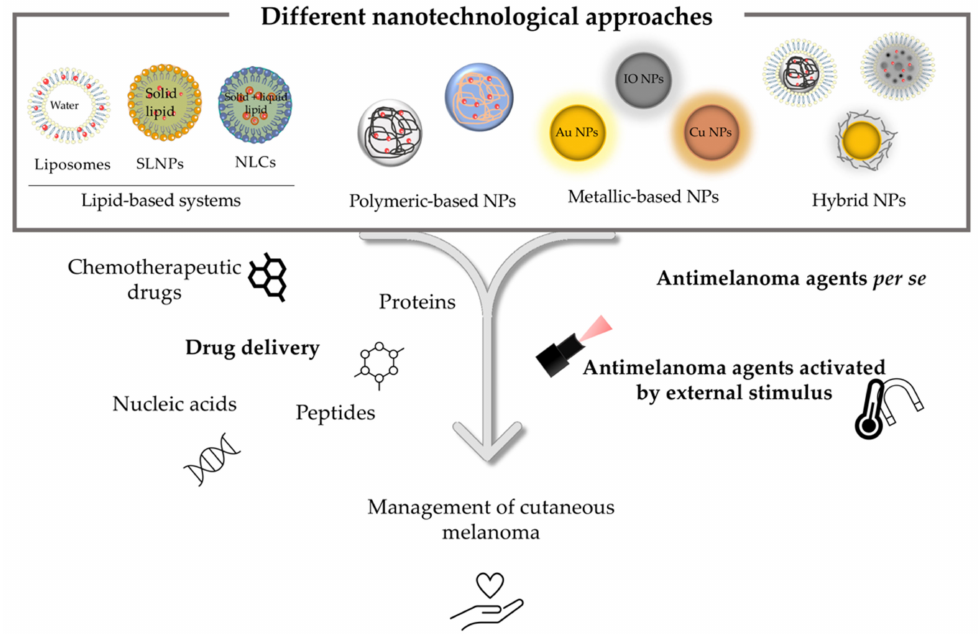
Figure 2. Schematic illustration of different types of nanosystems: lipidic, polymeric, metallic, and hybrids that can be used for loading chemotherapeutic drugs, proteins, peptides, nucleic acids, DNA, or for activation by external stimuli for melanoma